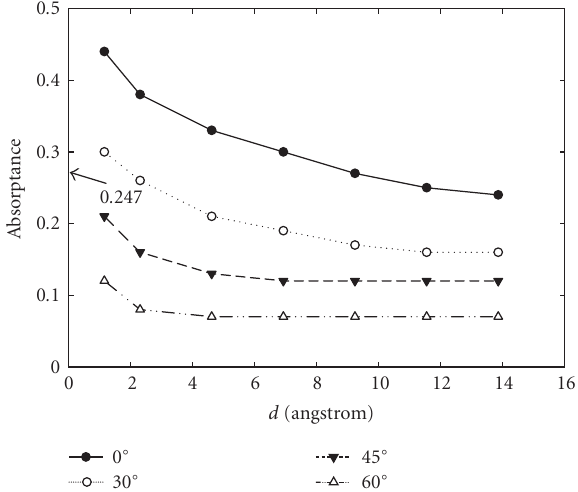
Figure 6: The dependence of absorptance on H/r in the case of semicircular texturing